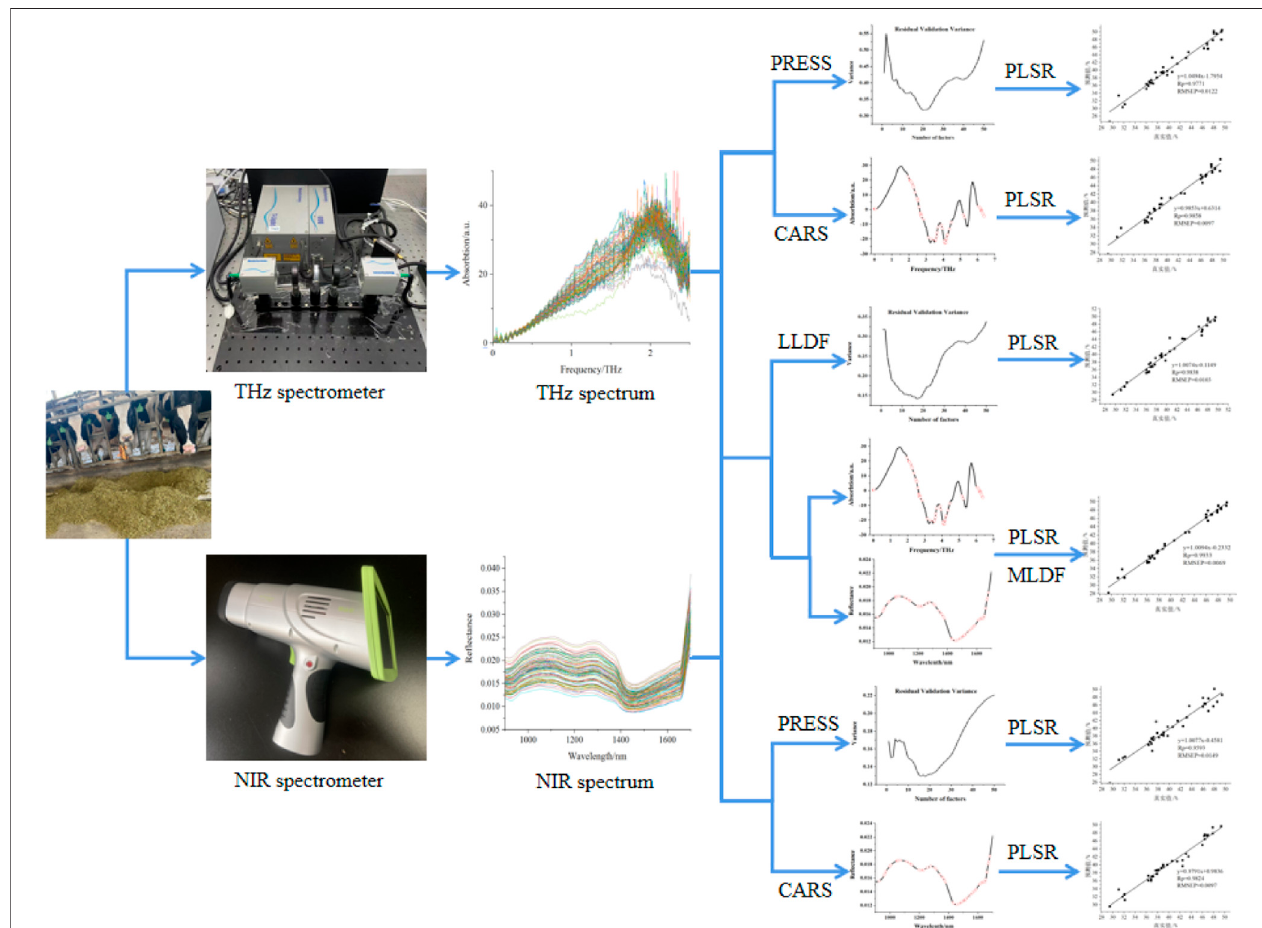
FIGURE 1 | Flowchart of the experimental process.